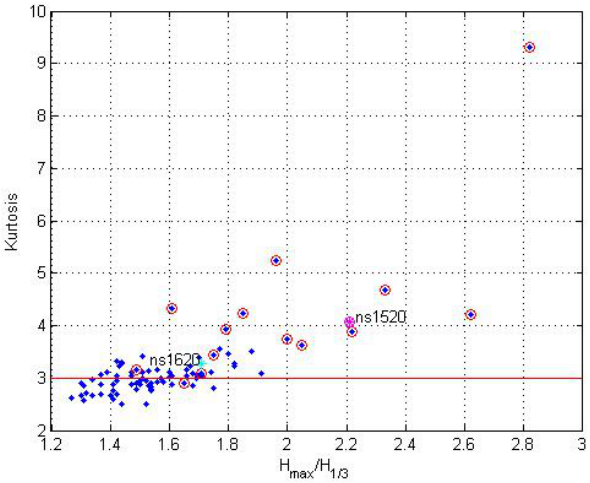
Figure 10. Correlation of corresponding kurtosis with the ratio of H max /H 1/3 . Again the points Fig. 10. Correlation of corresponding kurtosis with the ratio of with a red circle around are the visually picked freaque wave cases. H max / H 1 / 3 . Again the points with a red circle around are the vi- sually picked freaque wave cases.